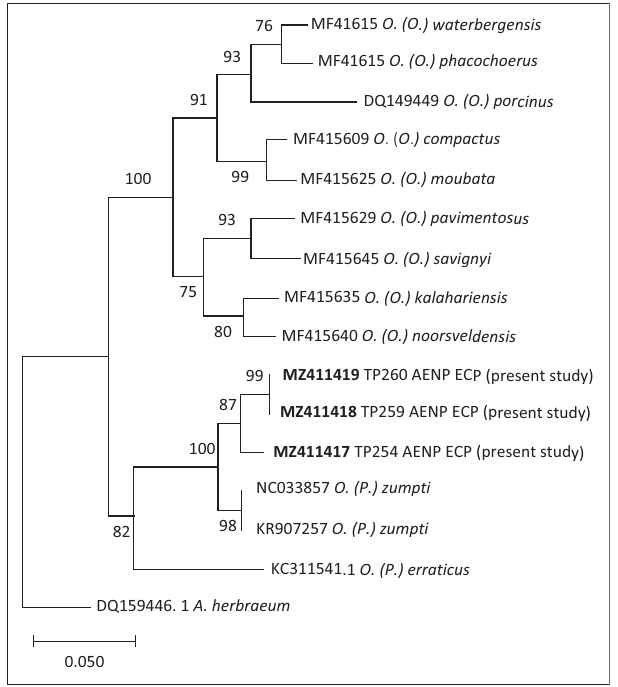
FIGURE 2 : Neighbour-joining tree based on partial mitochondrial 16S rRNA gene sequence (276 nt) depicting phylogenetic relationships between the 3 Ornithodoros (Pavlovskyella) zumpti tick pools from the present study (GenBank accession numbers in bold) and representative Ornithodororos species sequences from GenBank. The corresponding gene sequence of Amblyomma hebraeum was included as an outlier. Percentage bootstrap support values were derived following 10 000 replications. Evolutionary analyses were conducted in MEGA X software.